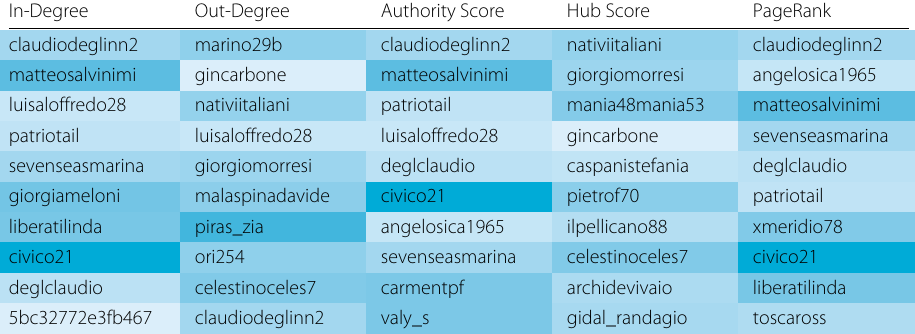
Table 4 PI3 retweet graph: top 10 accounts by centrality